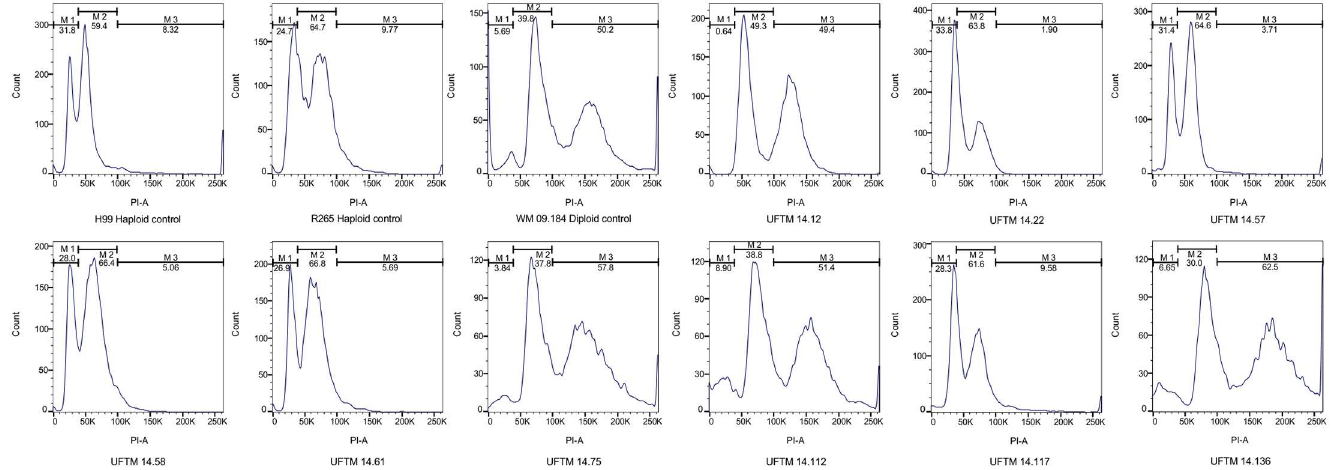
Fig 1. Representative flow cytometry curves of selected southeastern Brazilian Cryptococcus neoformans var. grubii VNI isolates. Out of 143 isolates, 12 were identifiedas diploid.The haploidstrains H99 C . neoformans var. grubii VNI and CDCR265 C . gattii VGII and the diploidhybrid strain WM 09.184 C . neoformans VNII/VNIV were includedin each flow run as